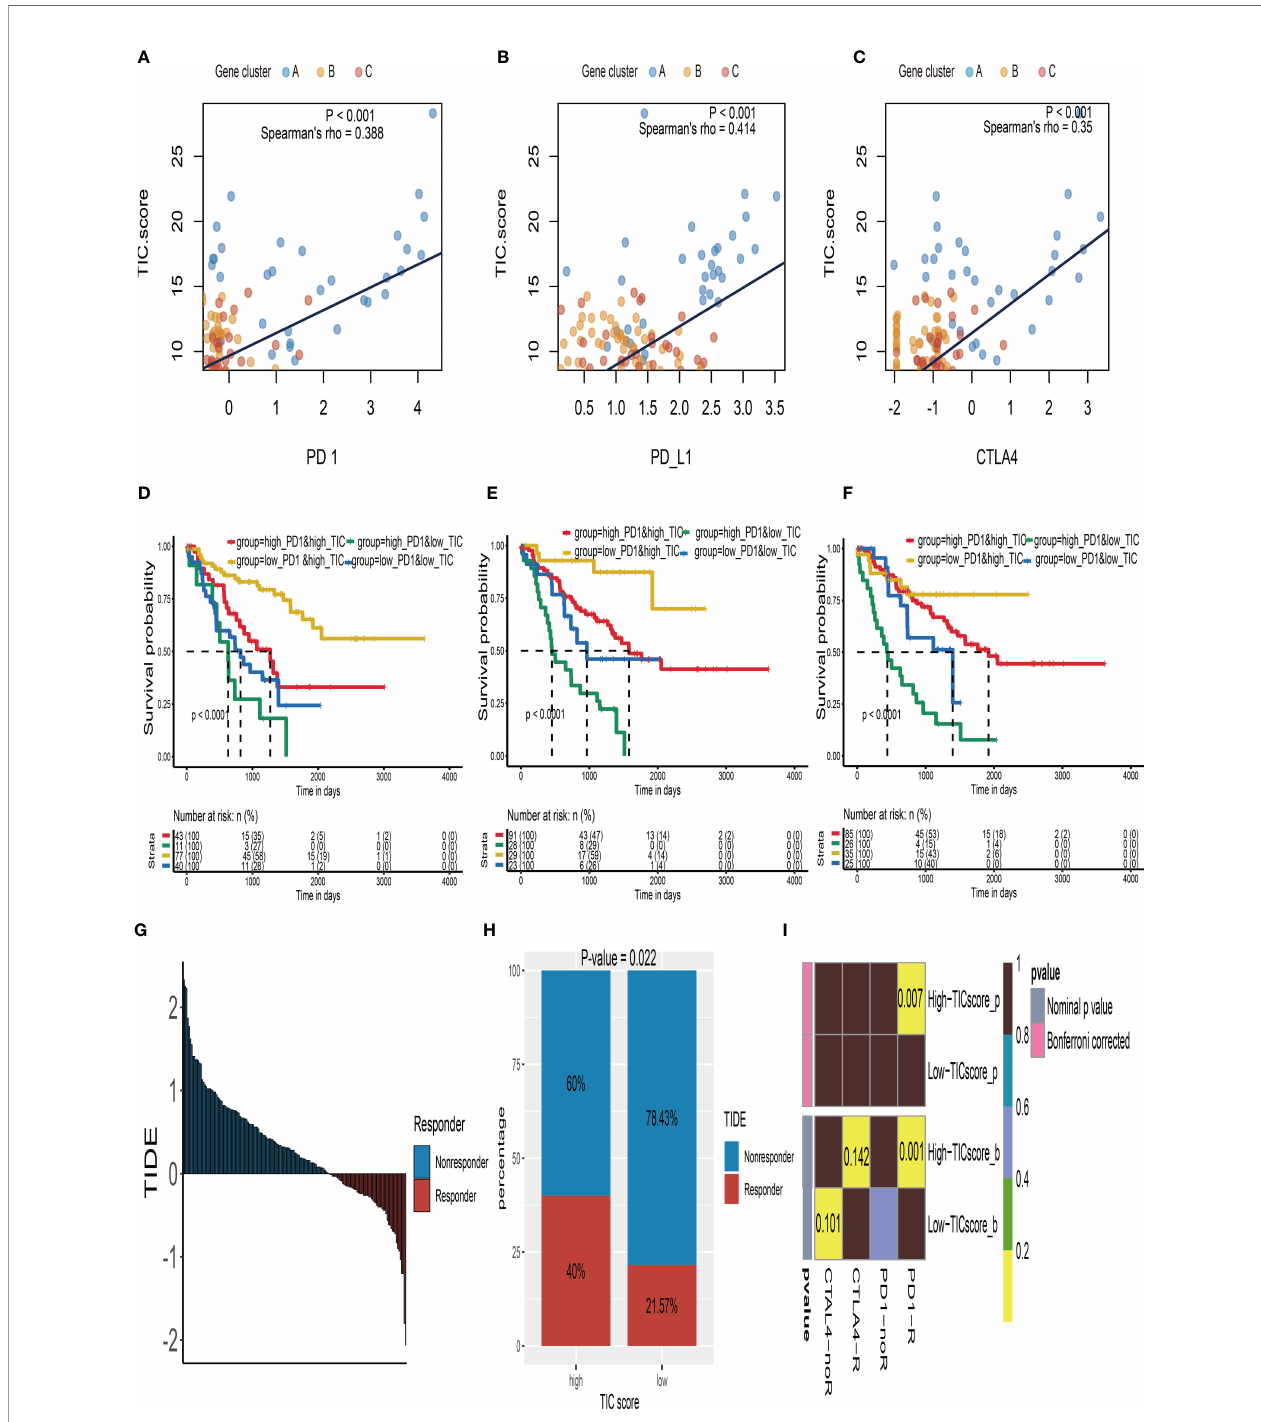
FIGURE 6 | Immune checkpoint therapy response of UM. (A) The correlation analysis between TIC scores and PD-1 expressions. (B) The correlation analysis between TIC scores and PD-L1 expressions. (C) The correlation analysis between TIC scores and CTLA-4 expressions. (D) Kaplan – Meier (KM) curve of four groups strati fi ed by the TIC scores and PD-1 expressions. (E) KM curve of four groups strati fi ed by the TIC scores and PD-L1 expressions. (F) KM curve of four groups strati fi ed by the TIC scores and CTLA-4 expressions. (G) The distribution of Tumor Immune Dysfunction and Exclusion (TIDE) scores in all UM patients. (H) The different response rate between high-TIC score and low-TIC score groups in terms of immunotherapy. (I) Anti-CTLA-4 and anti-PD-1 treatment responses in high- TIC score and low-TIC score